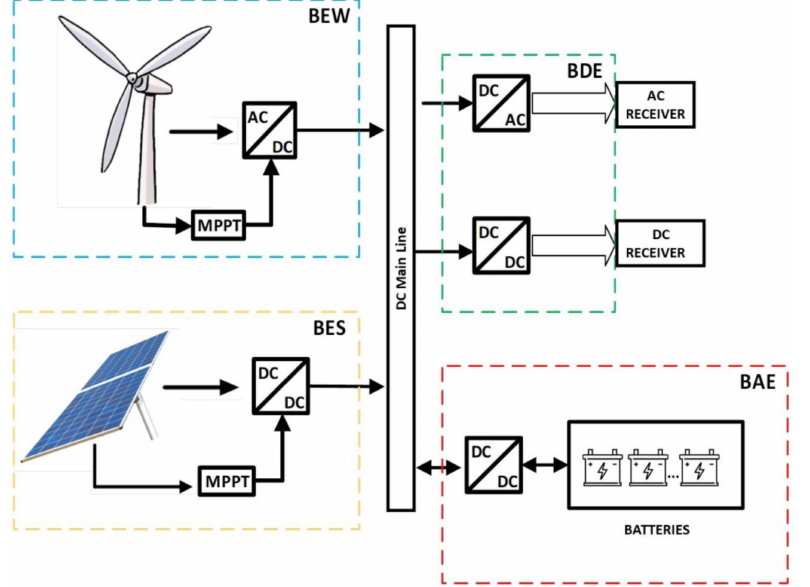
Figure 3. General operation scheme of a solar-wind power generator system (source, prepared by the